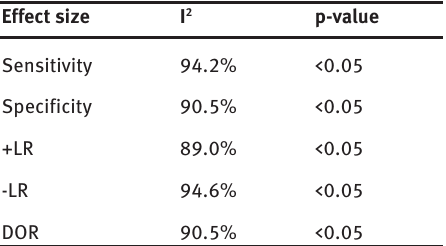
Table 2 : The statistical heterogeneity analysis of the 18 studies by I 2